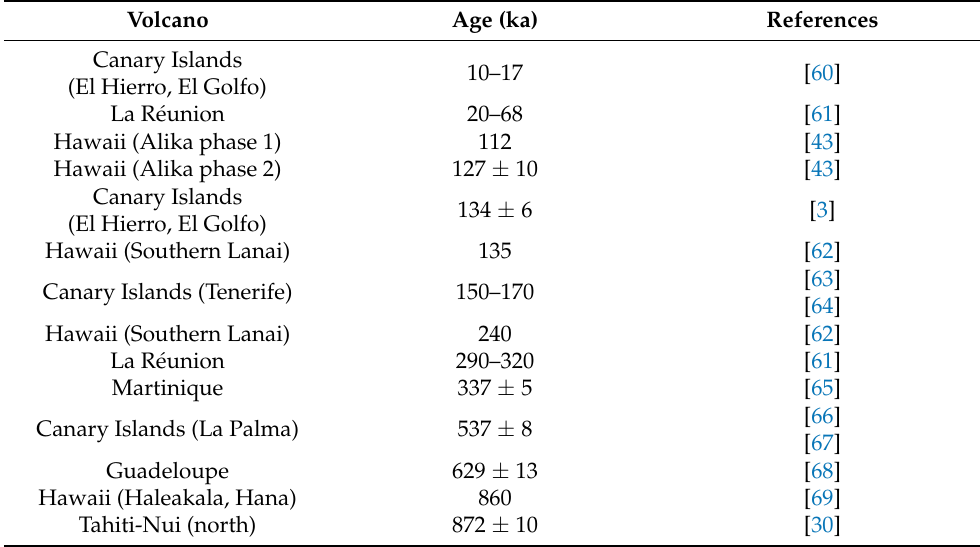
Table 1. Giant landslide ages in volcanic areas during the last 1 Ma. Volcano Age (ka) Canary